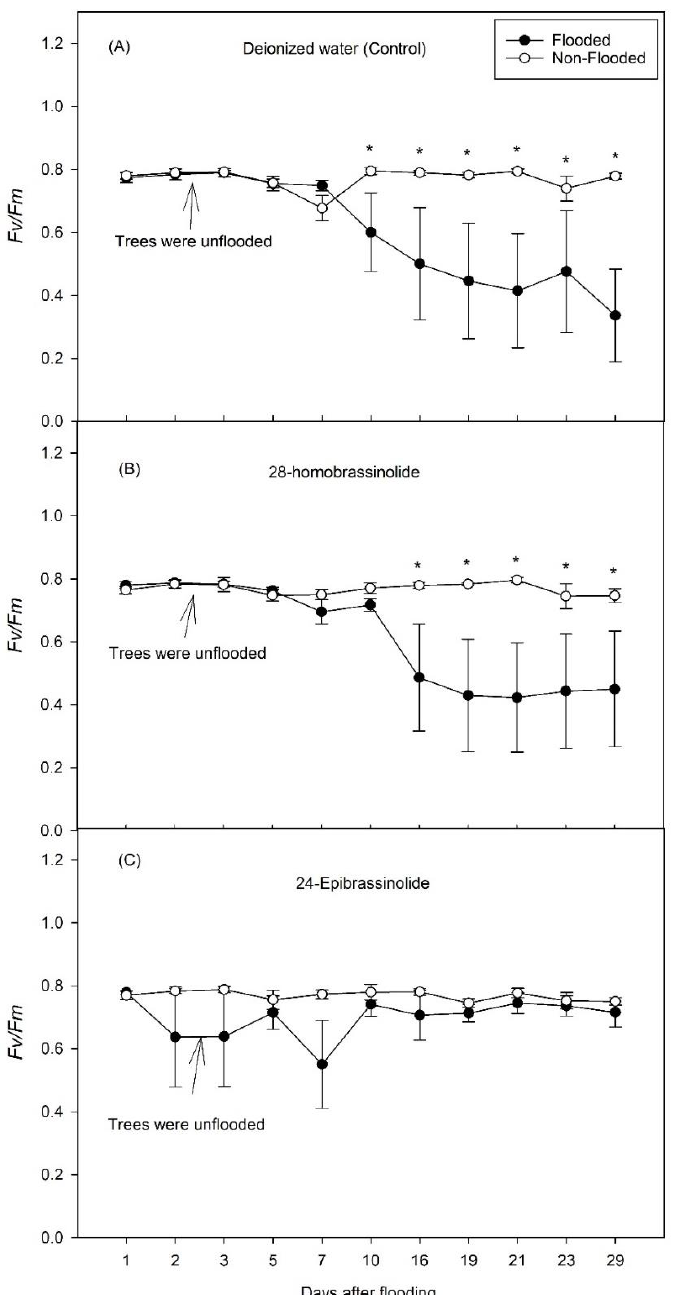
Figure 5. Effect of flooding on the maximal potential quantum efficiency of photosystem II ( Fv/Fm ) of ‘Monroe’ avocado trees treated with ( A ) deionized water as a control, ( B ) 28-homobrassinolide, or ( C ) 24-epibrassinolide, (Experiment 1). Symbols and bars indicate means ± std. err. Significant differences ( p ≤ 0.05) between flooding treatments are indicated with an asterisk and were determined by repeated-measures ANOVA. ‘Trees were unflooded’ indicates the day on which trees were removed from the flooding treatment to start the recovery period.